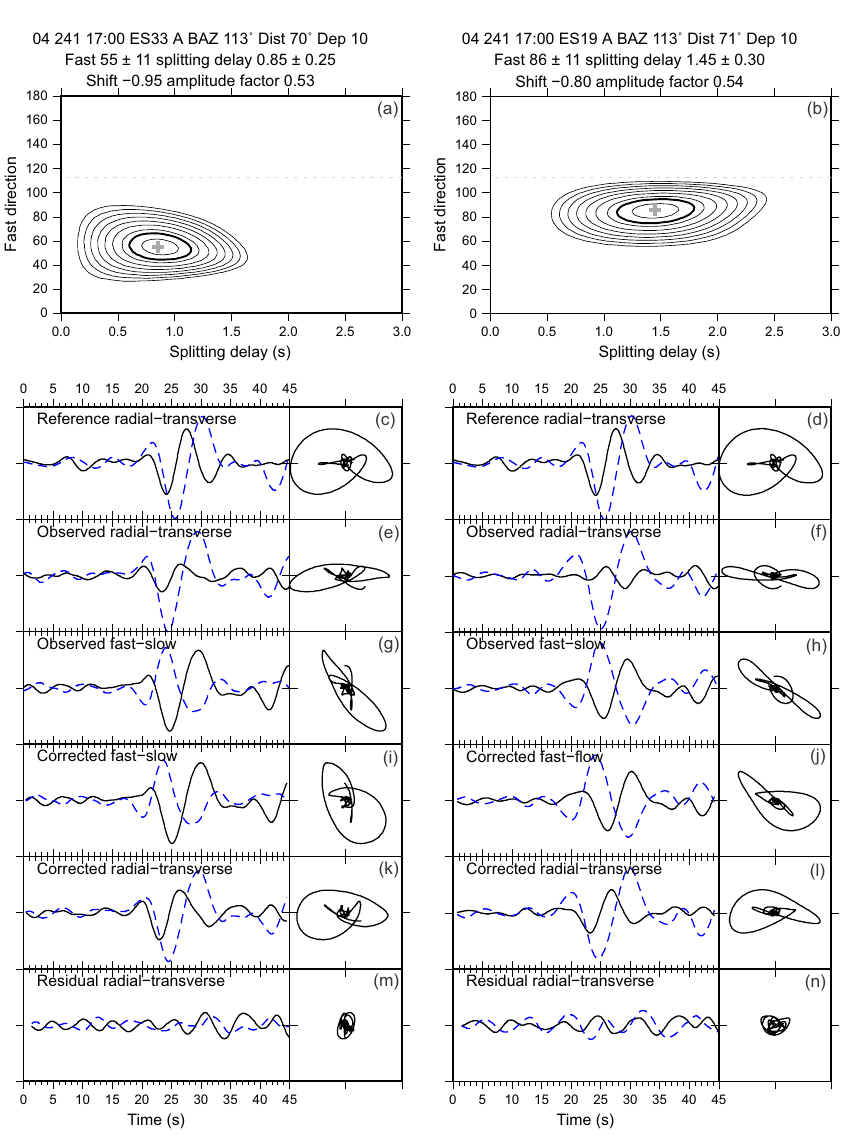
Figure 4. Examples of the direct S wave splitting measurements based on the reference station technique at stations ES33 and ES19, where previously null anisotropy was obtained using an SKS splitting measurement (Sol et al., 2007). Panels on the left side represent the splitting measurement observed at the station pair with ES12 (reference station) and ES33 (target station), and those on the right side represent the splitting measurement observed at the station pair with ES12 (reference station) and ES19 (target station). The explanation for each panel is the same as in Fig.